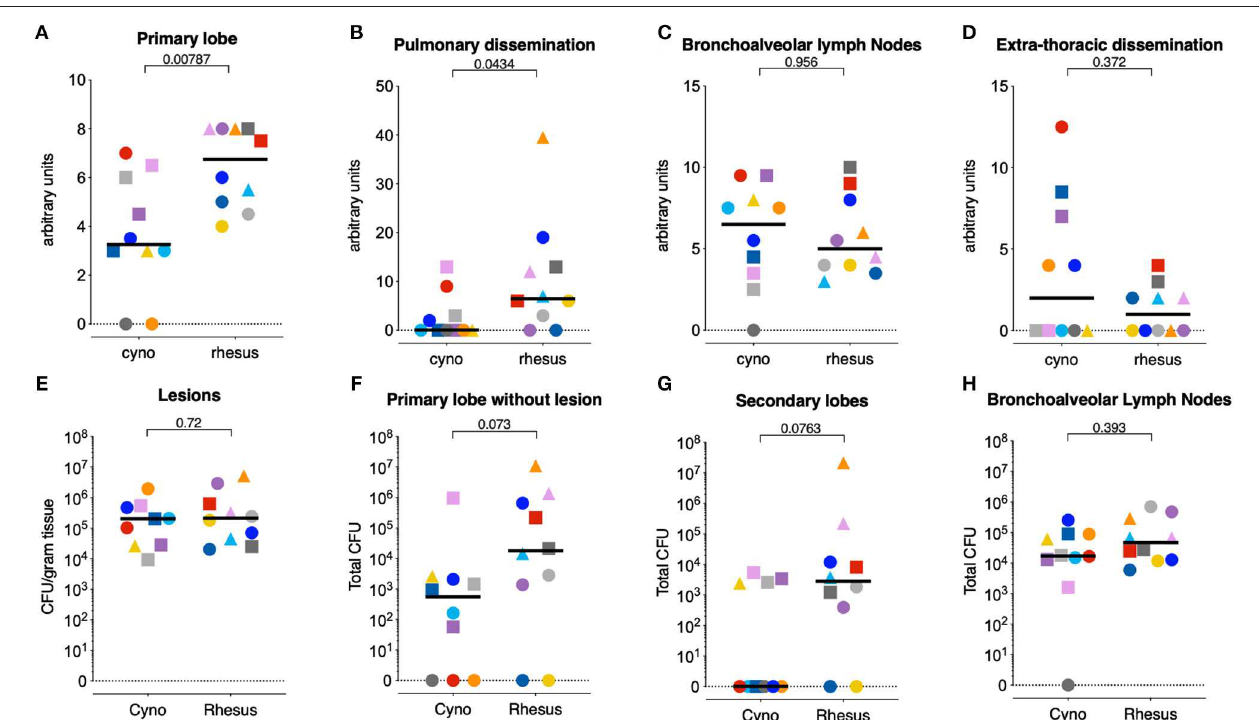
FIGURE 2 | Cynomolgus macaques exhibit less pulmonary tuberculosis disease after low dose Mtb infection. (A–D) Post-mortem scores of gross Mtb pathology in (A) the primary targeted lung lobe, targeted when challenging with Mtb , (B) all other lung lobes, as pulmonary dissemination, (C) the lung-draining lymph nodes, and (D) the extra-thoracic organs as extra-thoracic dissemination. (E–H) Quantification of bacterial load in homogenates (E) of individually collected and pooled lesions from the primary lobe, (F) of the remainder of the primary lung lobe (after collection of individual lesions), (G) of pooled secondary lung lobes, and (H) of lung draining lymph nodes. Circles represent animals that IGRA converted 3 weeks after 1.3 CFU challenge, squares represent animals that IGRA converted 3 weeks after 7 CFU challenge, and triangles represent animals that IGRA converted 4 weeks after 1.3 CFU challenge and received another 7 CFU of Mtb 1 week later. N = 10 per group, except for figure (E) , where n = 9 cynomolgus macaques, as one animal did not yield any macroscopic lesions. Horizontal lines indicate group medians. Significance of differences between species was determined by two sided Mann-Whitney testing. Color coding per individual, as defined in Table 1 , is consistently applied